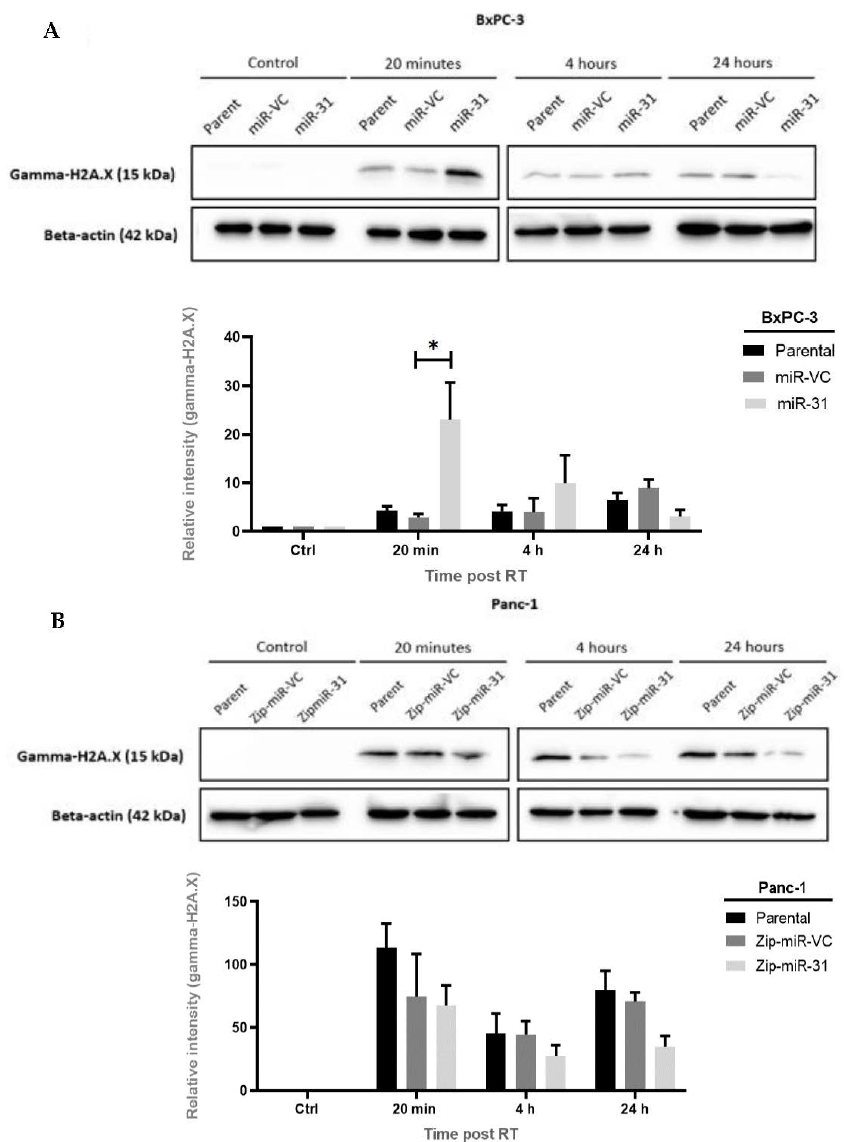
Figure 5. The expression of miR-31 positively correlates with DNA damage incurred when treated with radiation. ( A ) Representative Western blot time course and densitometric analysis for gamma-H2A.X as a marker of DNA damage following radiation treatment (RT) in BxPC-3 cells. Significant increases in gamma-H2A.X levels were observed in the BxPC-3 miR-31 cells 20 min (* p = 0.0120) post-RT. Interestingly, levels of gamma-H2A.X were reduced, with no significant differences observed at 4 h ( p = 0.932) and 24 h ( p = 0.939) post-RT. ( B ) Representative Western blot time course and densitometric analysis for gamma-H2A.X as a marker of DNA damage with RT (4 Gy) in Panc-1 cells. It is evident that levels of gamma-H2A.X decreased in Panc-1 Zip-miR-31 cells, however, no significant differences were observed at 20 min ( p > 0.999), 4 h ( p = 0.990), and 24 h post-RT ( p = 0.664). Data are represented as the mean ± SEM ( n = 3). Two-way ANOVA with Tukey’s post-hoc test was adopted for statistical